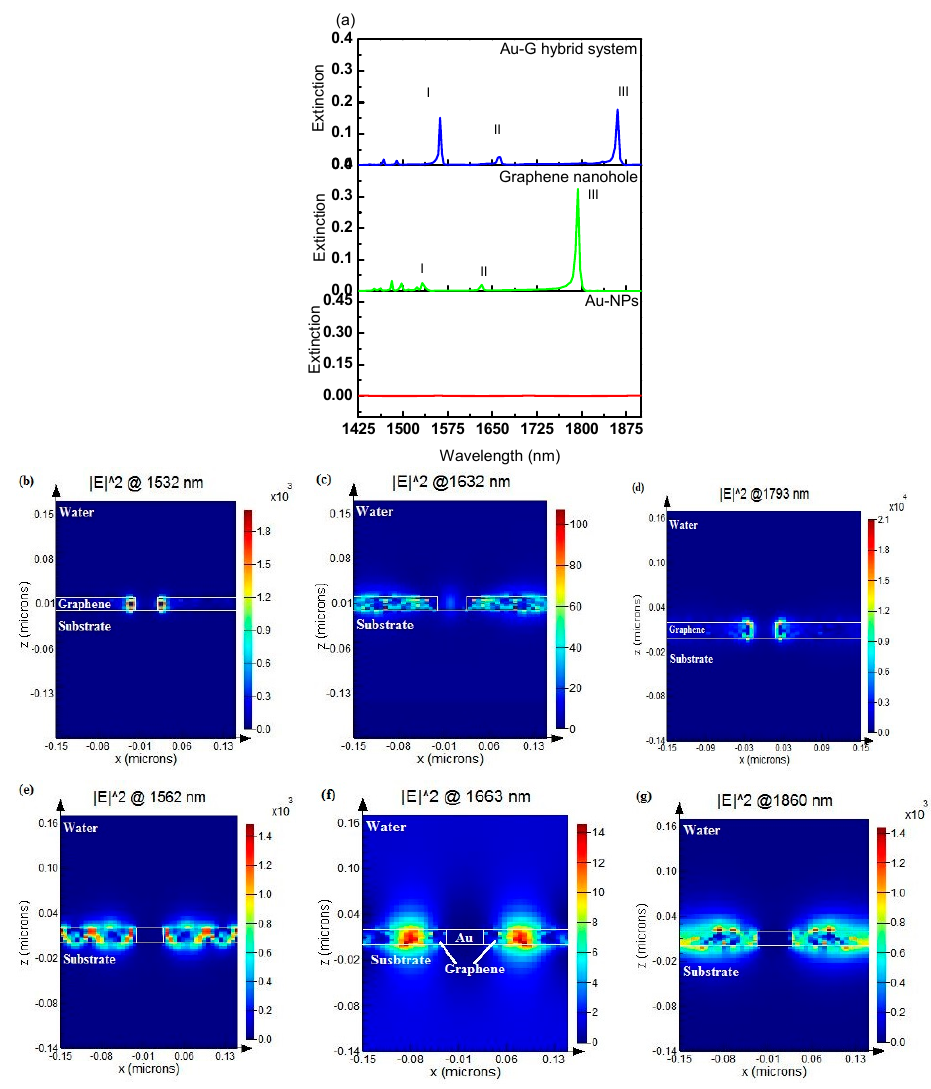
Figure 2. Top row: ( a ) extinction spectrum for three different nanostructures; Au NP square array, nanohole array perforated in 20 nm thick graphene film, and Au NPs/G hybrid structure. Middle row: electric field profiles at the resonance wavelengths of ( b ) 1532 nm (mode I), ( c ) 1632 nm (mode II), and ( d ) 1793 nm (mode III) of the graphene nanohole structure. Bottom row: Au-graphene hybrid structure at resonance wavelengths of ( e ) 1562 nm (mode I); ( f ) 1663 nm (mode II), and ( g ) 1860 nm (mode III), respectively.